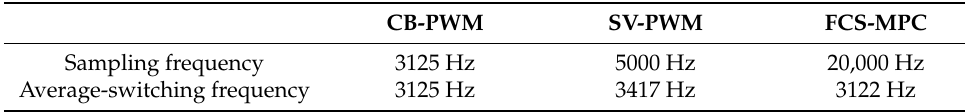
Table 2. Sampling and average switching frequencies